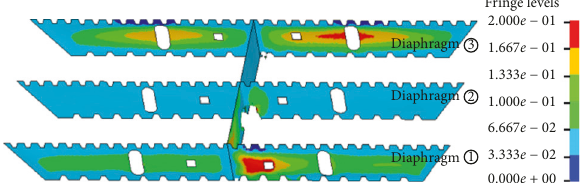
Figure 15: Fringe plot of diaphragm’s displacement (unit: